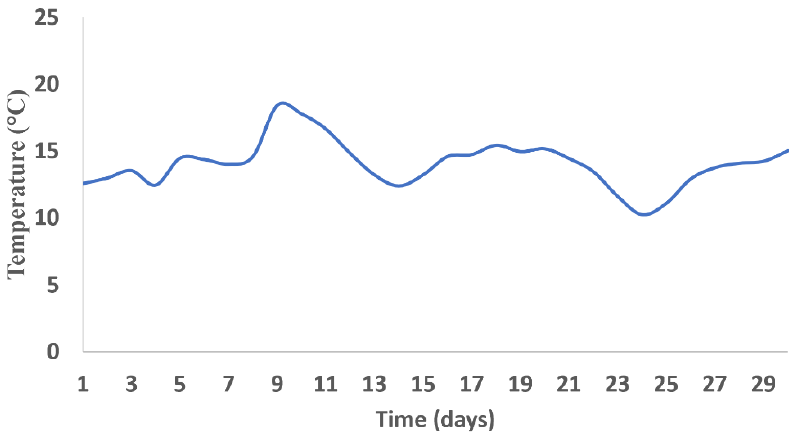
Figure 8. Weather data for the city of Sala EL Jadida during March 2019 [30].